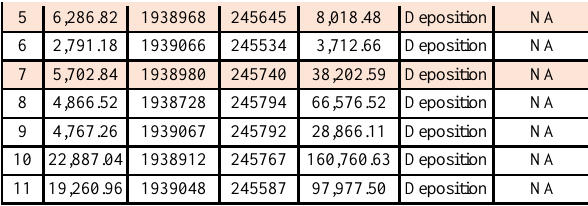
Table 4 . Remaining Landslide Volume.